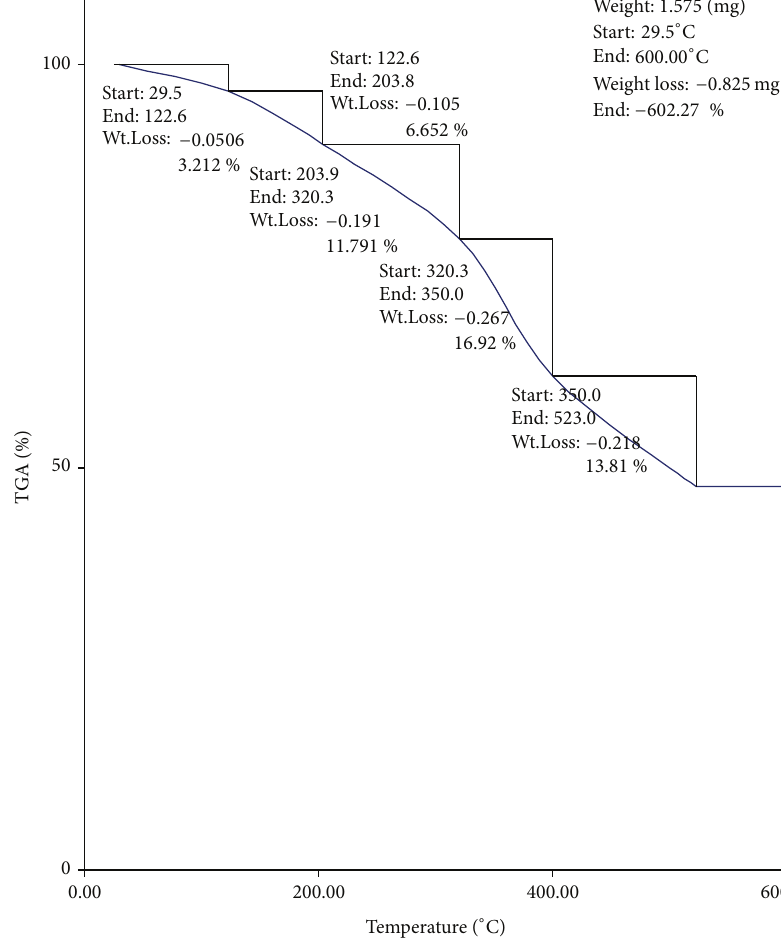
Figure 14: The thermal gravimetric analysis (TGA) for (POPDA).